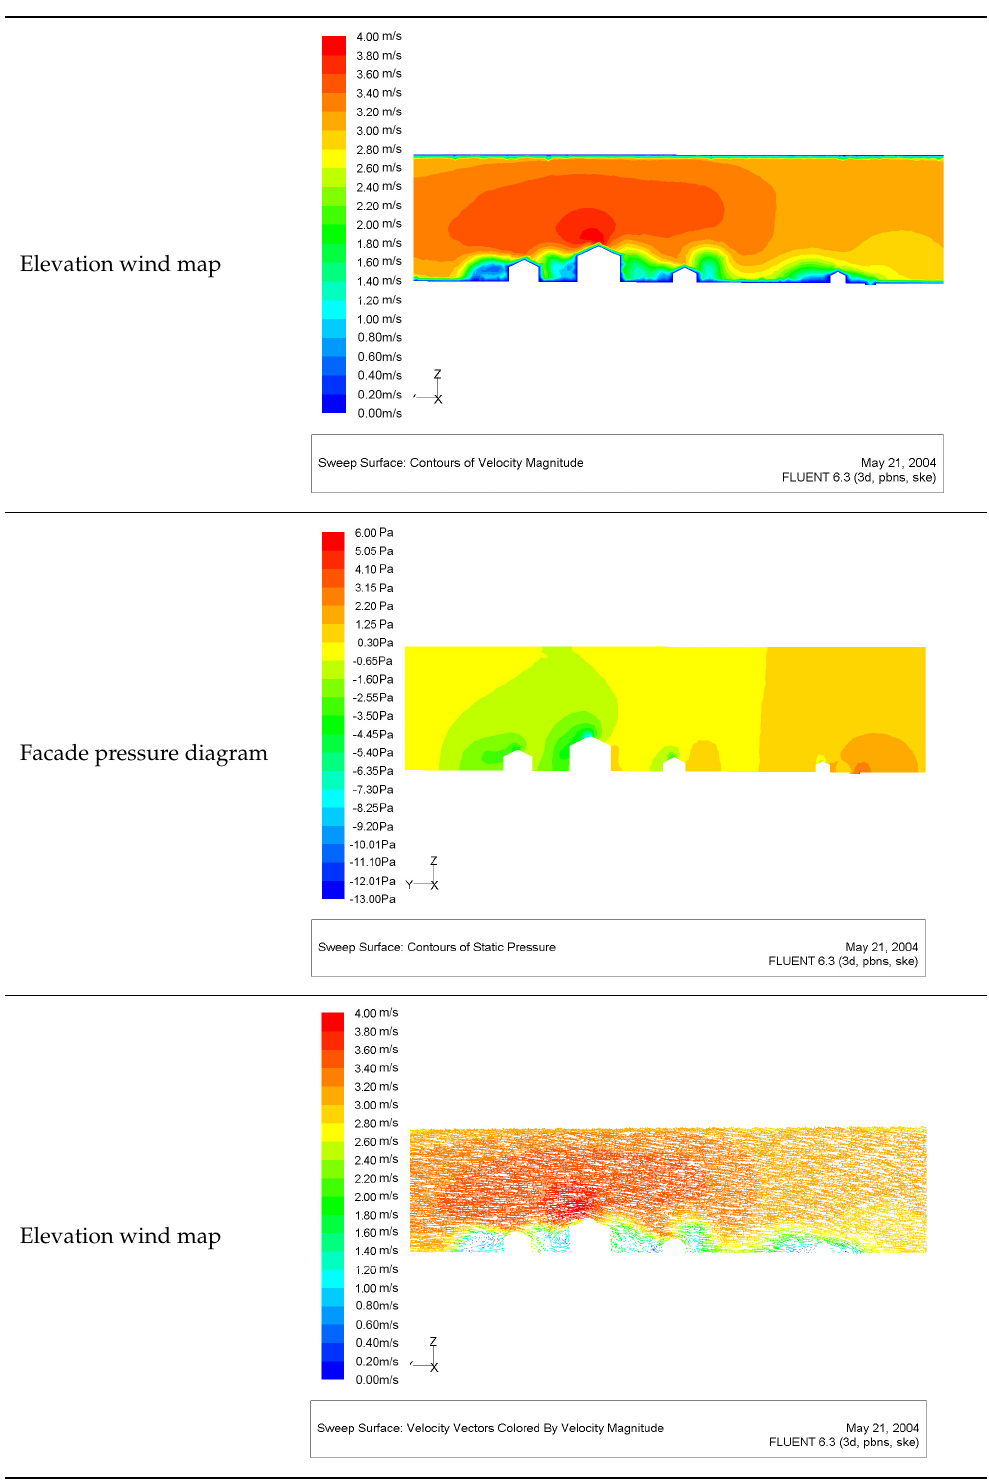
Table 2. The elevation wind map of the temple after the reconstruction, the wind pressure map and the wind vector.